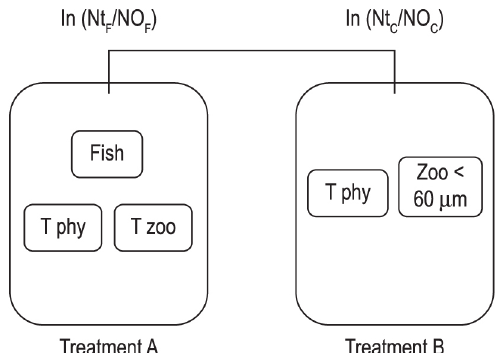
Figure 1. Experimental design. Treatment A (with fish), Treatment B (control, no fish), T phy = total phytoplankton, T zoo= total zooplankton, zoo < 60 µm= zooplankton < 60 µm, Nt = biovolume in t days F in treatment A, N0 = initial biovolume in treatment A, F Nt = biovolume in t days in treatment B, N0c = initial C biovolume in treatment